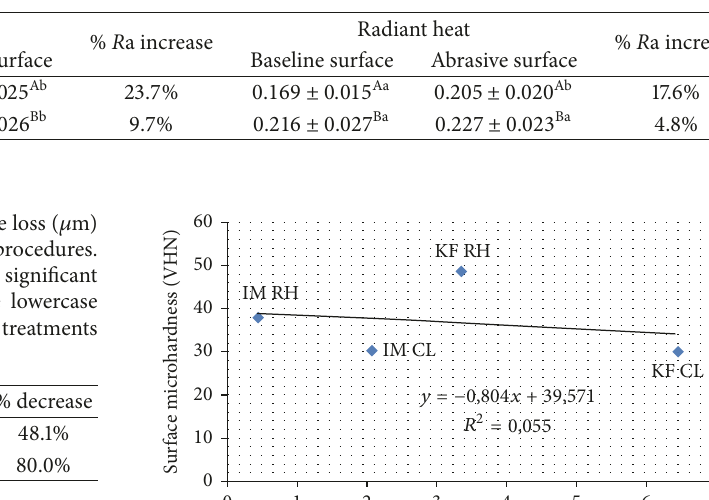
Table 3: Mean values and standard deviations of surface roughness ( R a, 𝜇 m) of the covered and uncovered surface of the specimens of the experimental groups of the study after abrasive procedure. The same uppercase superscripts in columns indicate no significant differences between materials (𝑝 > 0.05) . The same lowercase superscripts indicate no significant differences between treatments (𝑝 > 0.05) .